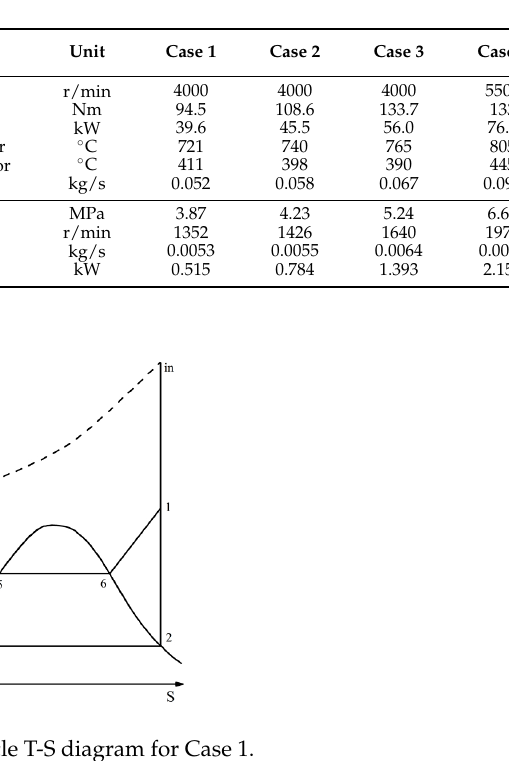
Table 4. Test results of the Rankine recovery system.